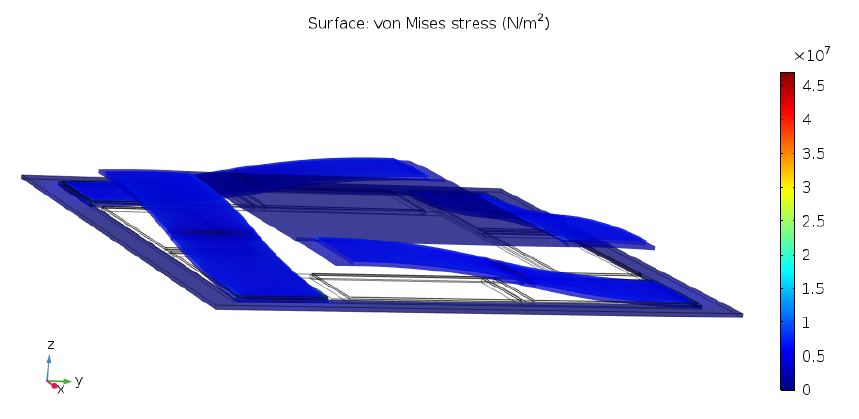
Figure 12. von Mises Stress in the joint connecting the end point of the staircase actuator to the load. It can be seen that, compared to the cantilever actuator and for a load that does not permit rotation with respect to the xy -axis, the stress induced by the staircase actuator is considerably lower. This is also a novel and useful result adding further to the potential for this